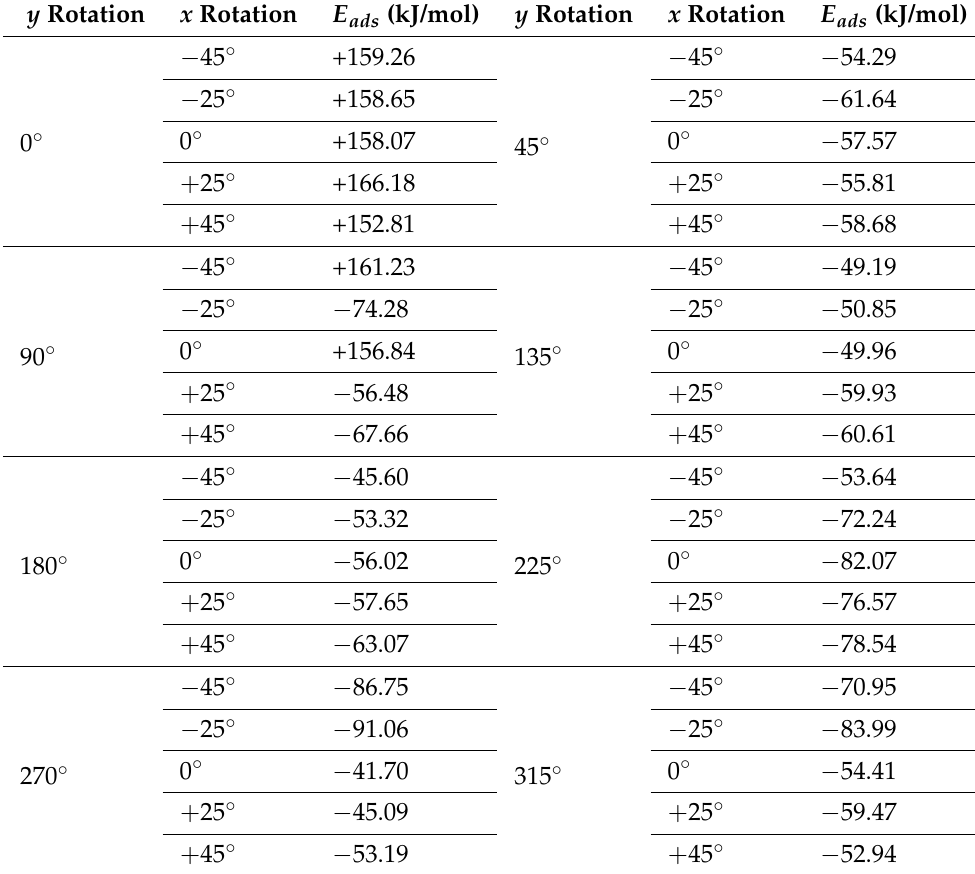
Table 1. Calculated E ads